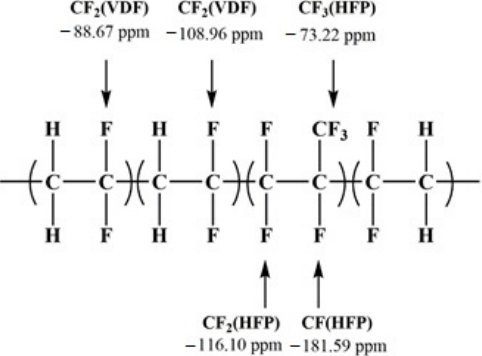
Figure 7. Sequence of repetitive units in Fluoline HY.